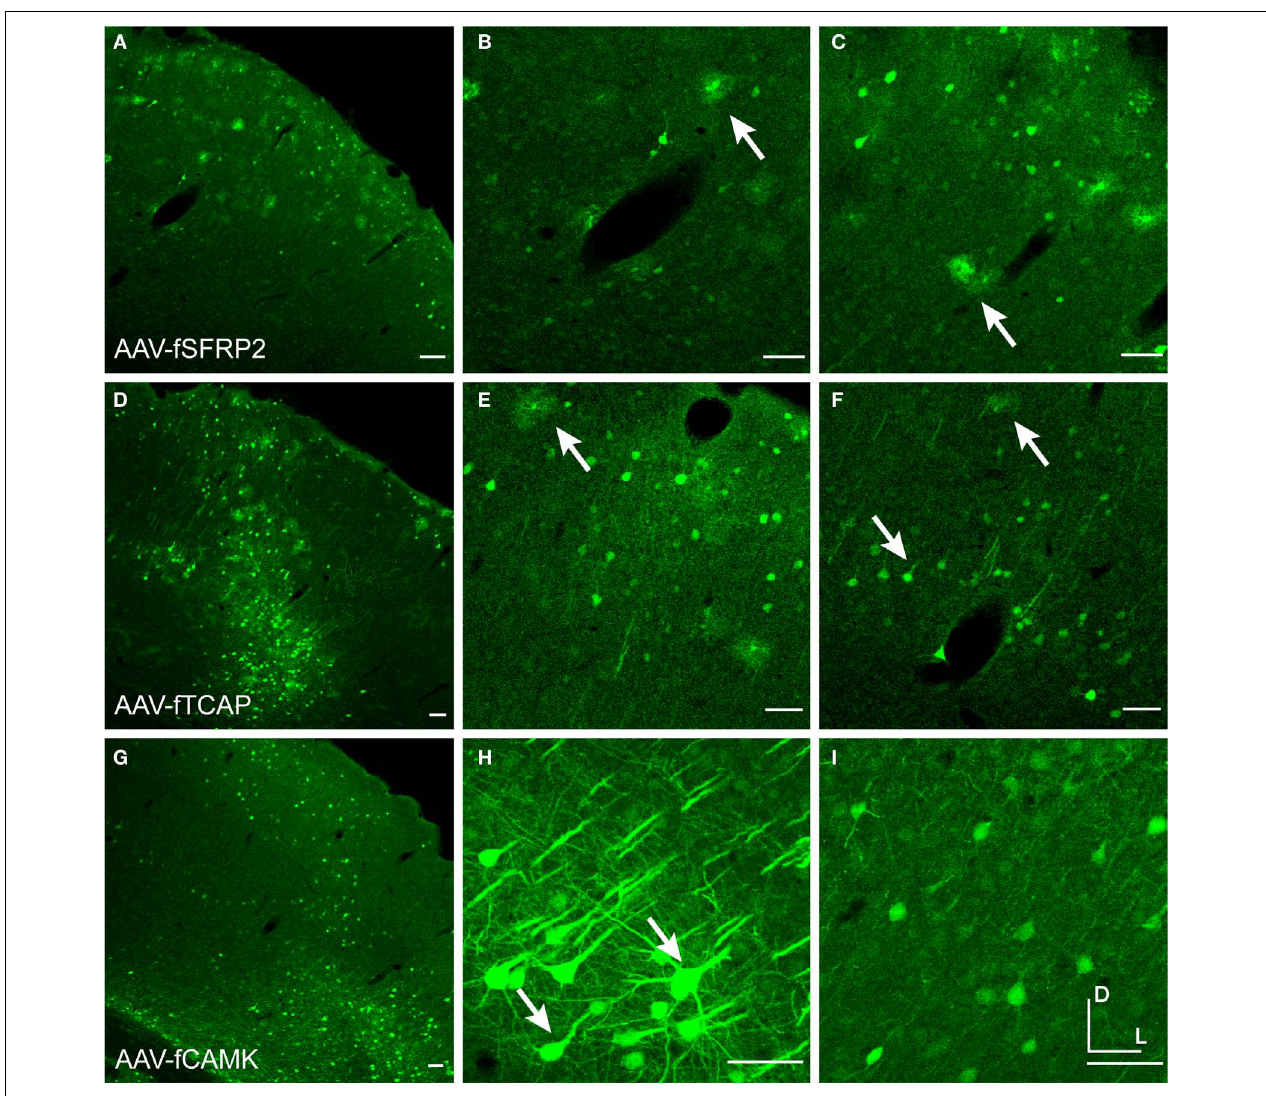
promoters in AAV are shown in rows: secreted frizzled-related protein 2 [AAV-fSFRP2, (A–C) ], titin-cap [AAV-fTCAP, (D–F) ] and α -calcium/calmodulin- dependent protein kinase II [AAV-fCAMK, (G–I) ]. Upward arrows mark glia and downward arrows mark excitatory pyramidal neurons. Dorsal (D) and lateral (L) directions for all images are as indicated in (I) . Scale bars are 50